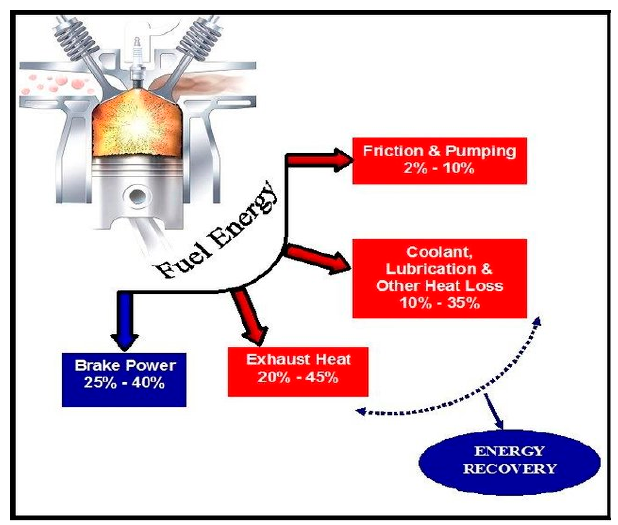
Figure 1. Variation total fuel energy content in ICE.